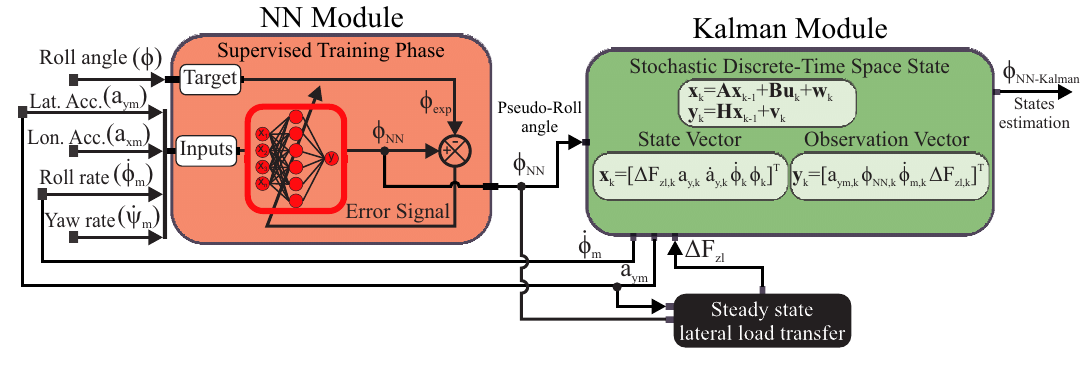
Figure 1. Estimator architecture.